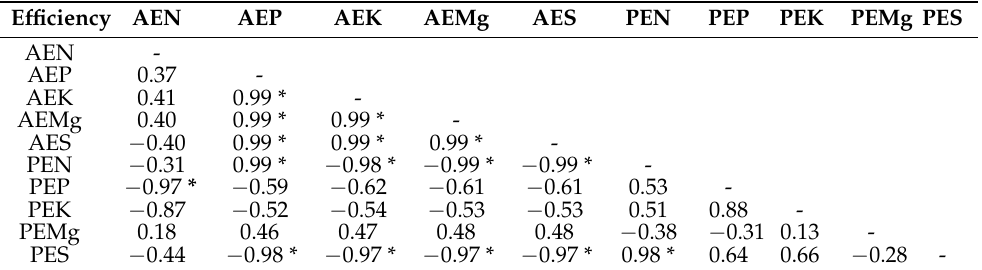
Table 9. Correlation coefficients for the relationship between AE (N, P, K, Mg and S) and PE (N, P, K, Mg and